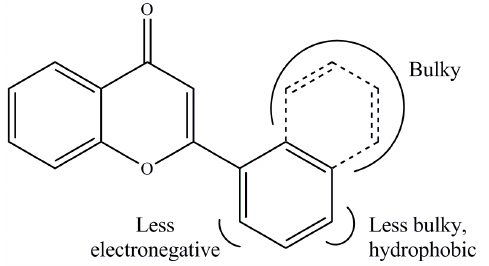
Figure 3. Pharmacophores derived based on the CoMFA and CoMSIA models.